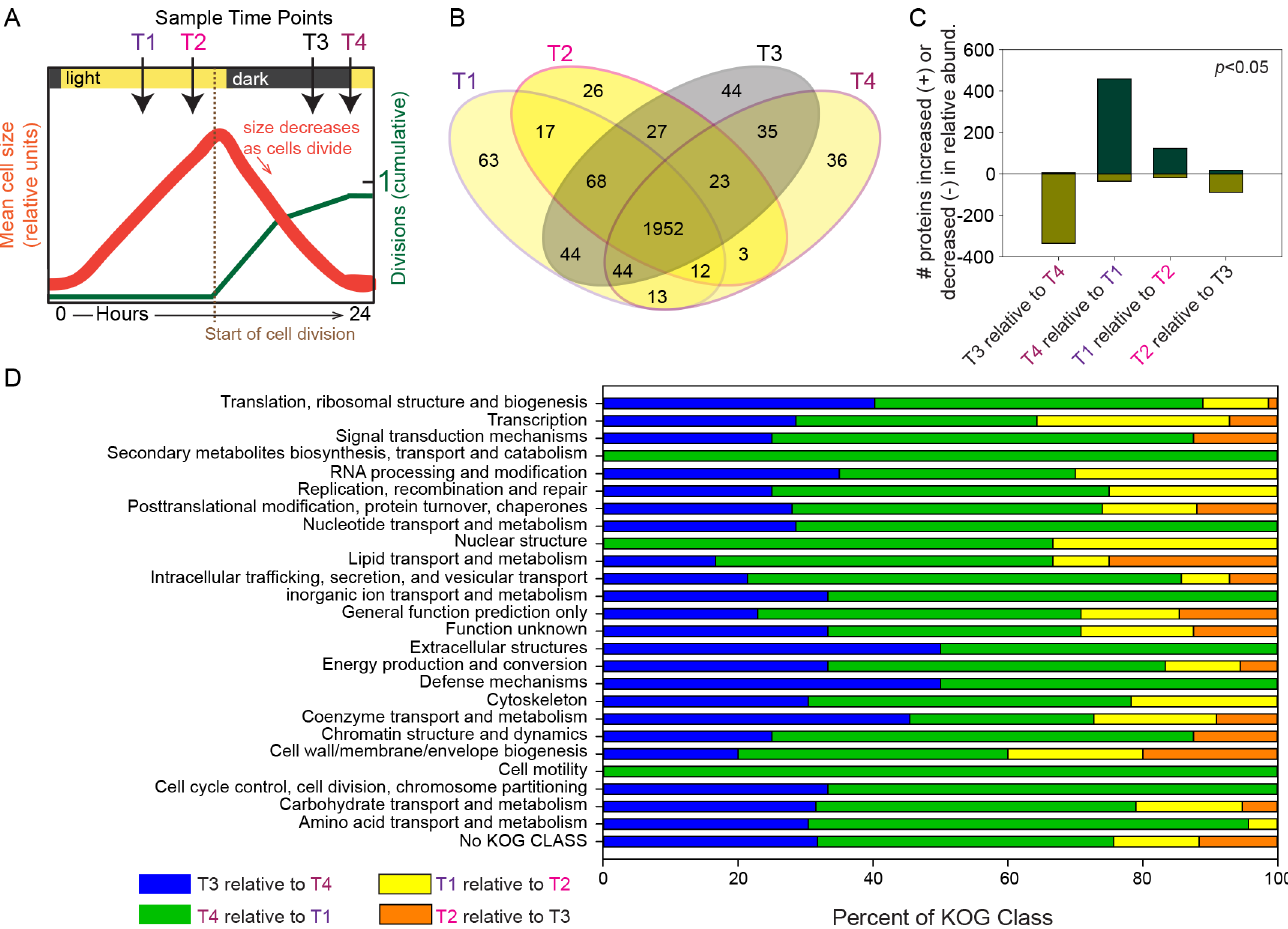
Fig 1. Experimental design and global dynamics of the Micromonas pusilla proteome. (A) Cartoon modeling cell growth and size during the diel experiment based on details of cell growth provided in [3]. Sampling points are marked with arrows. (B) Distribution across the sampled time points of proteins from the nuclear genome. Observation within at least 50% of proteomics datasets (technical and biological replicates), and identification by (cid:3) 2 unique peptides (i.e., matching only one protein in the genome) were required for categorization as “ present ” and inclusion here. A unique peptide is one that matches only one protein in the genome. A substantial number of proteins were observed across all time points. (C) Relative quantification comparison of global proteome expression over the course of the diel cycle. A progressive shift in the number of proteins exhibiting differential abundance ( p < 0.05) was observed when progressing from dark to light. The largest increased proteome response was observed at the introduction of light (T4), and this response decreased with time until relative abundance favored the dark condition. (D) KOG class assignments for proteins that exhibited relative abundance differences ( p < 0.05). For three KOG classes, 100% of proteins increased in abundance when comparing T4 to T1, suggesting that these classes are strongly influenced by circadian regulation in M . pusilla .